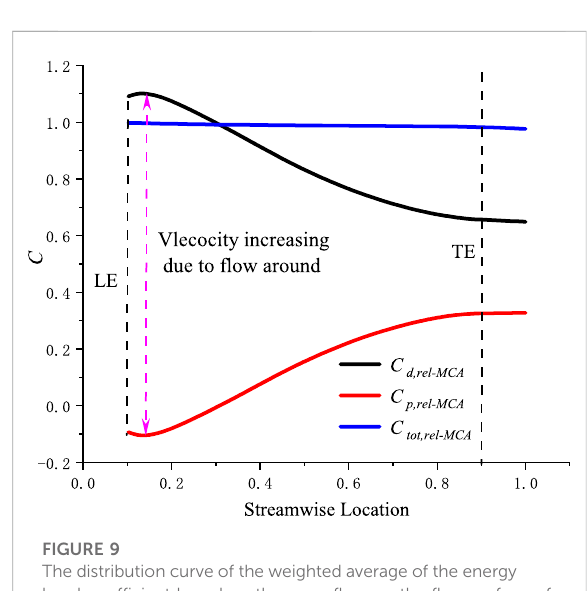
FIGURE 9 The distribution curve of the weighted average of the